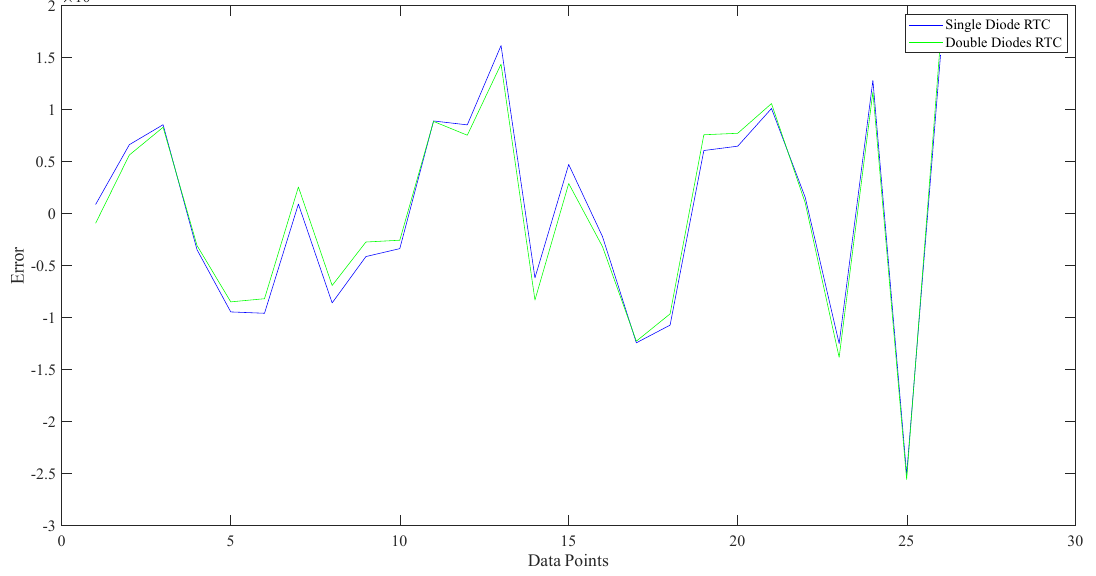
Figure 11. Error vs. data points for single diode and double diodes—RTC silicon photovoltaic cell.